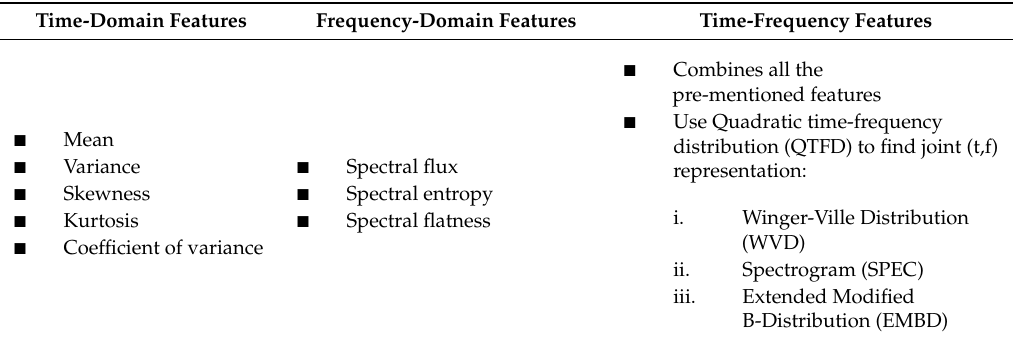
Table 2. Features extracted from the ECG